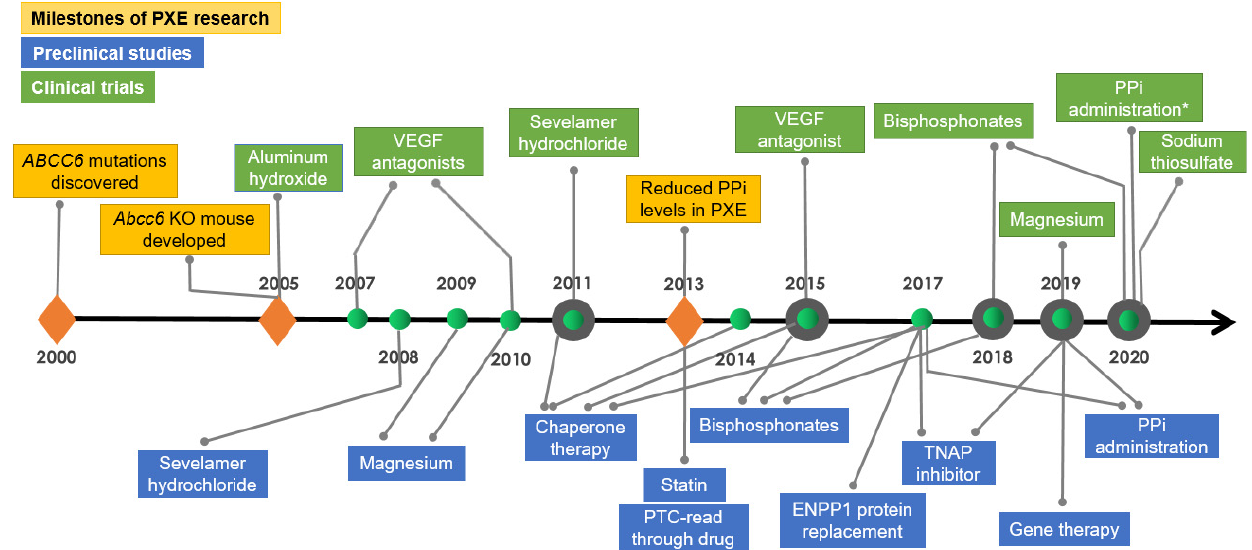
Figure 2. Milestones in PXE research, preclinical studies, and early clinical trials . The events are reported in chronological order and refer to the year of publication, except inorganic pyrophosphate trial (asterisk), which is registered as a clinical trial at early stages of development. Table 2. Interventional preclinical studies and early clinical trials for PXE, GACI, and ACDC, published and on-going. Treatment